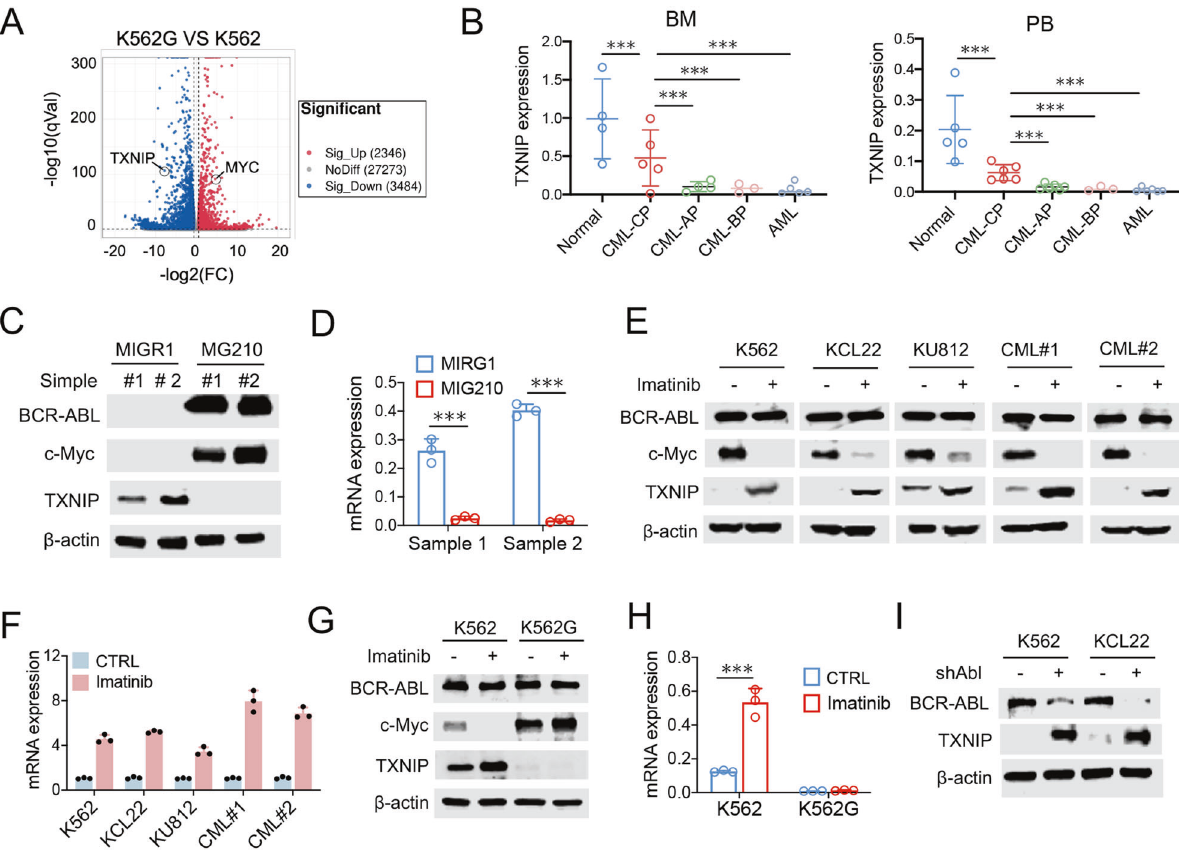
Fig. 1 TXNIP is downregulated by BCR-ABL transformation. A Volcano plot representing the genes signi fi cantly differentially expressed in K562 and K562G ( P < 0.05). B Relative mRNA levels of TXNIP in the PB and BM were compared among samples from normal healthy donors and patients as described in the fi gure. Each individual dot represents 1 sample. CP, chronic phase; AP, accelerated phase; BP, blast phase. C , D TXNIP protein ( C ) and mRNA ( D ) levels after BCR-ABL transduction (MIG210) in normal CD34 + cells from 2 independent healthy donors. Empty vector MIGR1 was used as a control. E , F TXNIP protein ( E ) and mRNA ( F ) levels in indicated CML cells 24 h after 0.5 μ M imatinib treatment. G , H TXNIP protein ( G ) and mRNA ( H ) levels in K562 and K562G cells 24 h after 0.5 μ M imatinib treatment. I TXNIP protein levels